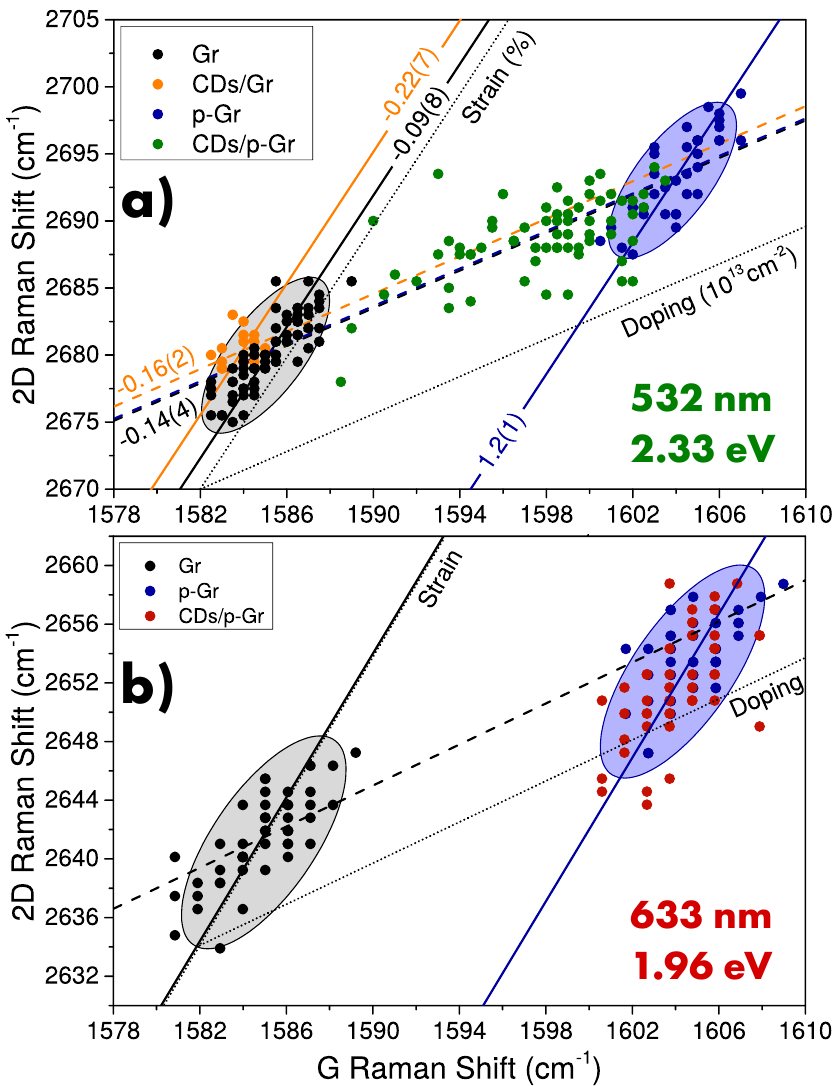
Figure 6. G-2D correlation graph at ( a ) 532 nm and ( b ) 633 nm laser excitation of undoped (black dots) and p-doped Gr (blue dots) (reported from Reference [44] for 532 nm only), CDs/Gr (orange dots), and CDs/p-Gr(green/red dots). Doping and strain axes are marked by dotted lines and reference levels are pointed out by continuous and dashed lines,